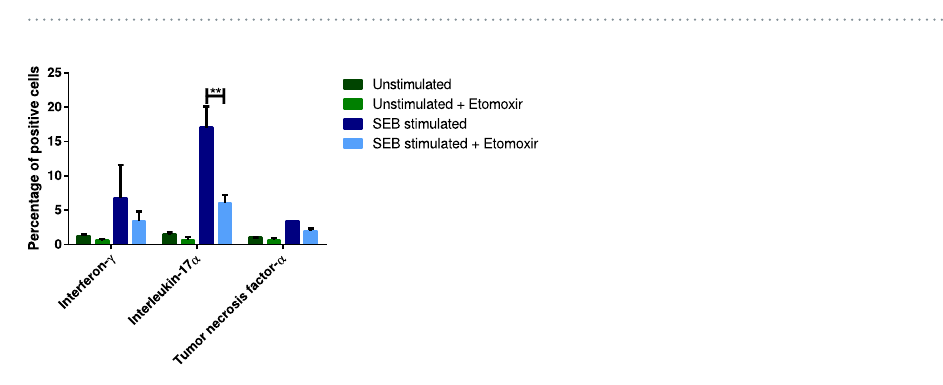
Figure 4. Percentage of hedonic animals after treatment with Escitalopram and Etomoxir. The results from Fischers exact test showed significant difference between treatment with Etomoxir (n = 20) and vehicle (n = 9) ( *** p = 0.0001–0.001). There was no statistical significance between Escitalopram (n = 14) and vehicle.